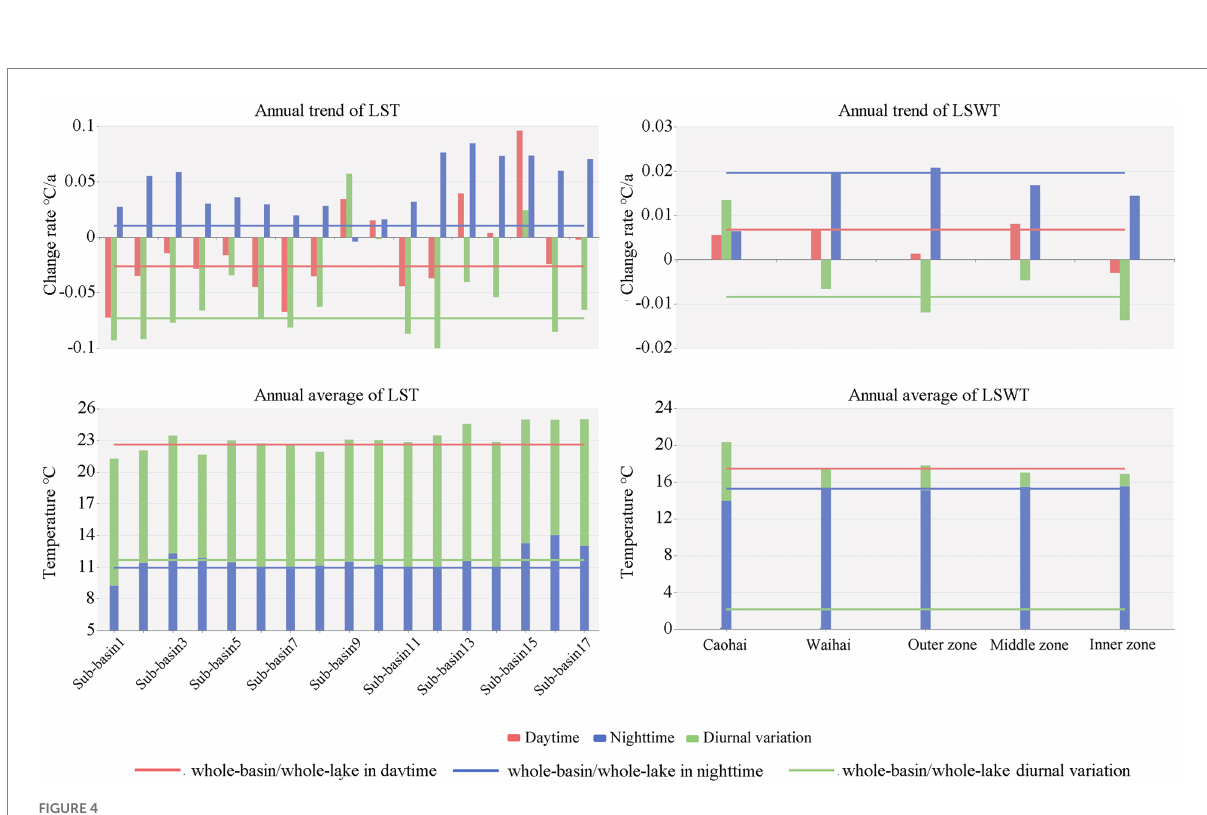
FIGURE 4 Spatial differences in temperature